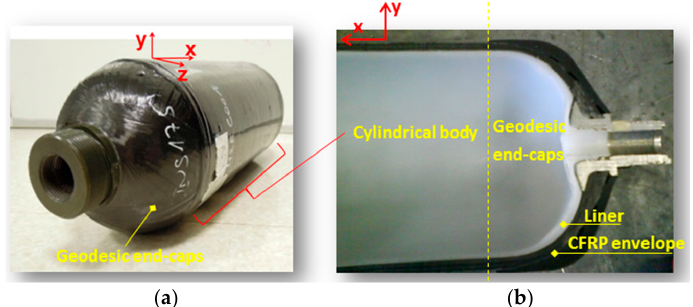
Figure 2. Example of a multi-layer COPV intended for housing hydrogen gas at high pressures: overview ( a ) and partial sectional view ( b ).